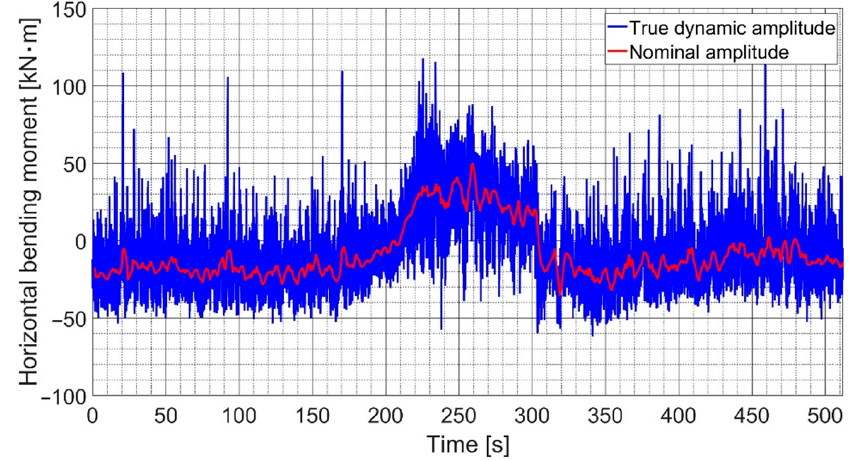
Figure 8. True dynamic bending moment in the horizontal direction during rapid port turn.